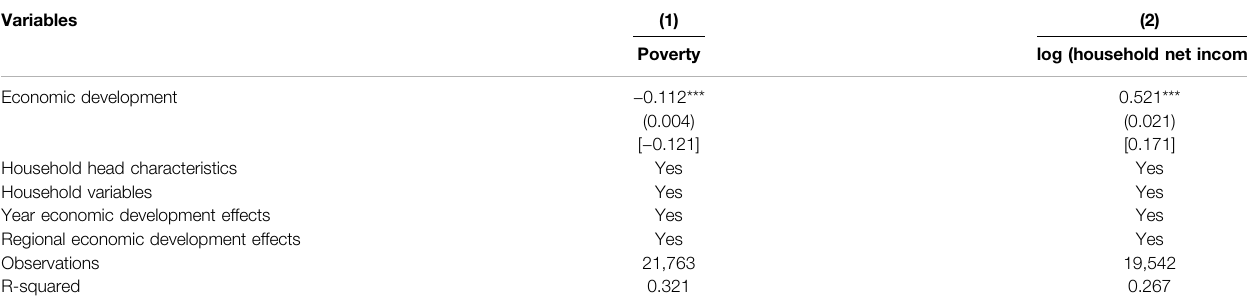
TABLE 5 | Effect of economic development on energy